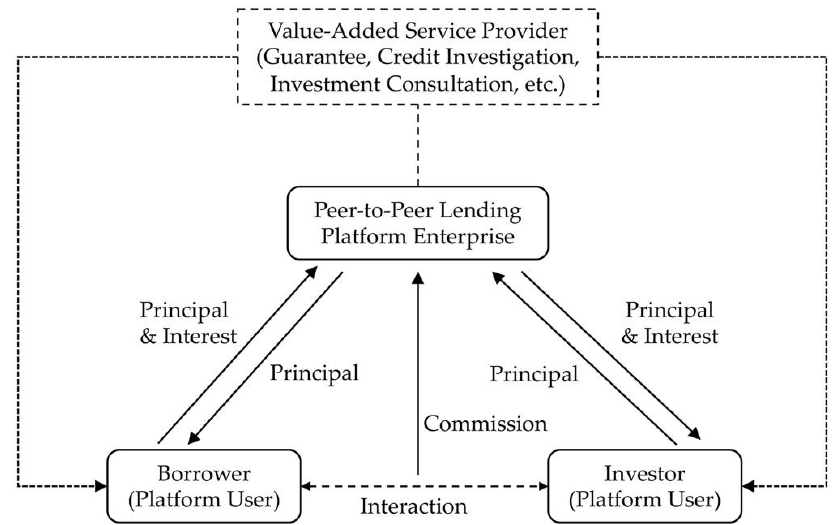
Figure 1. Transaction volume of China’s peer-to-peer lending industry from 2011 to 2019. Note: The data were obtained from WDZJ (http://www.wdzj.com, accessed on 20 July 2021); Unit: CNY 1 billion.